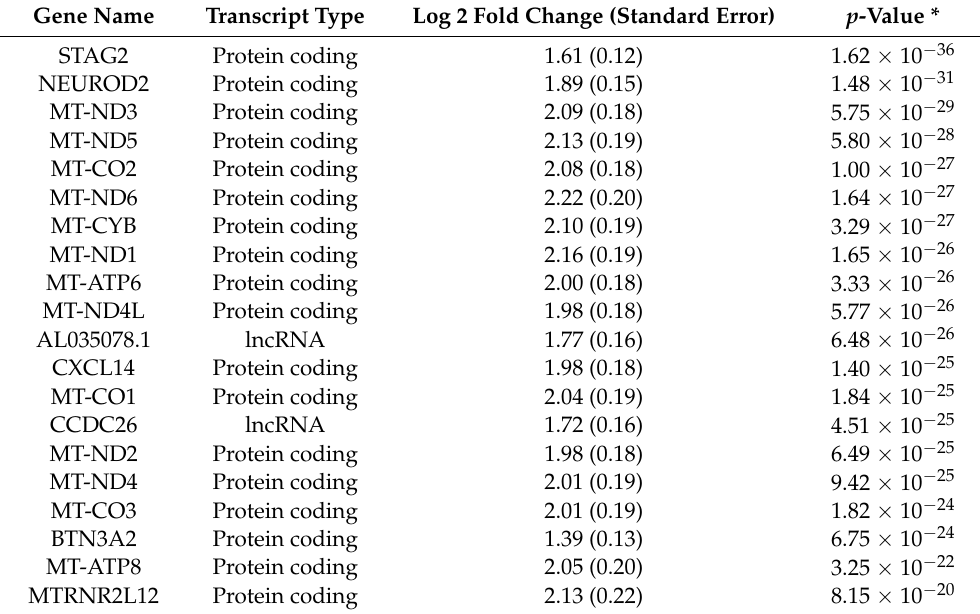
Table 3. The most differentially abundant mRNA and lncRNA transcript fragments in plasma from patients compared with